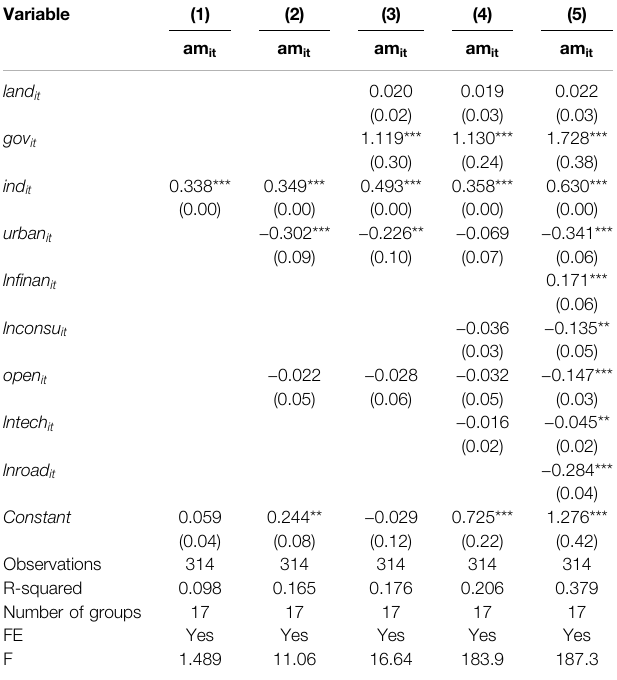
TABLE 6 | Stepwise regression results of the econometric model for the effects of multidimensional contributing factors of the SMCL. Variable